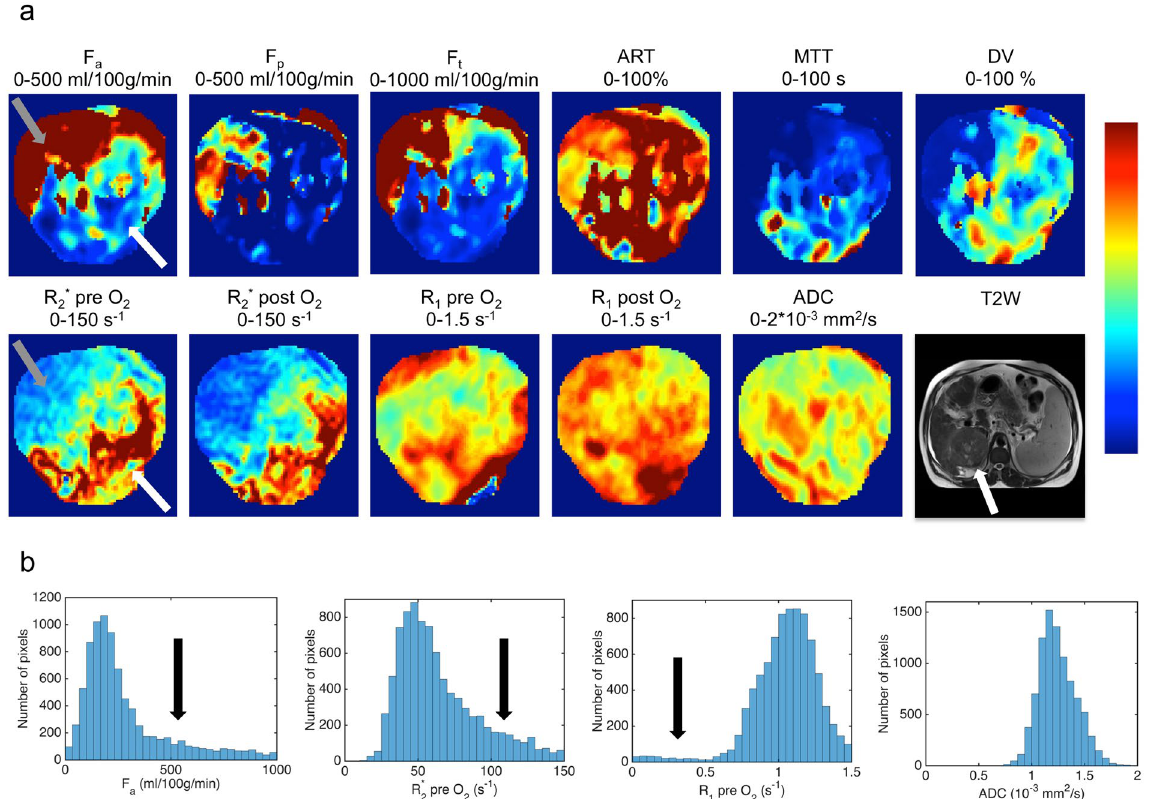
is indicated by the white arrow on the T 2 -weighted image (bottom row, right). A distinct region in the anterior portion of the tumour of high arterial flow (F a ) and low R 2 * was observed, reflective of high tumour perfusion and normoxia (grey arrow in F a and R 2 * pre O 2 maps). The posterior portion of the tumour displays low F a and high R 2 * , suggestive of poor perfusion and hypoxia (white arrow in F a and R 2 * pre O 2 maps). ( b ) Histograms of